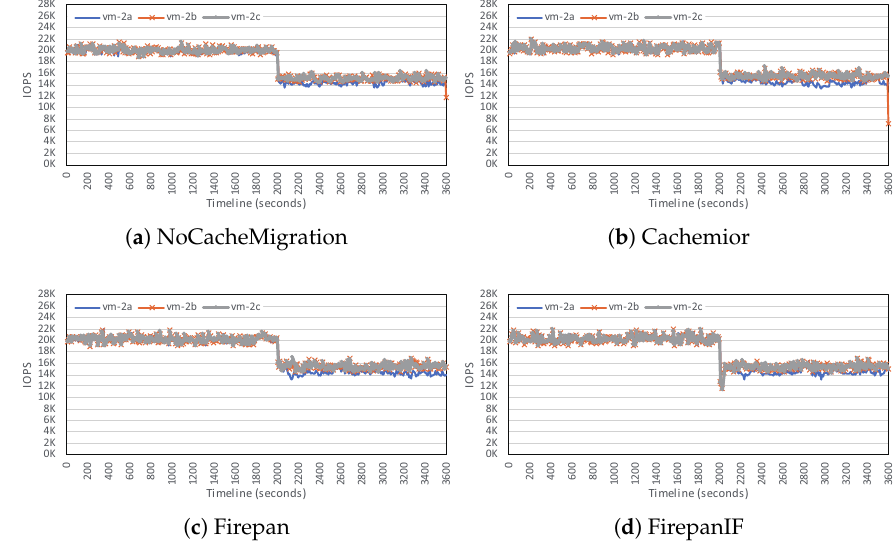
Figure 9. Performance of neighbor VMs on the destination host with NoCacheMigration, Cachemior, Firepan, and FirepanIF.